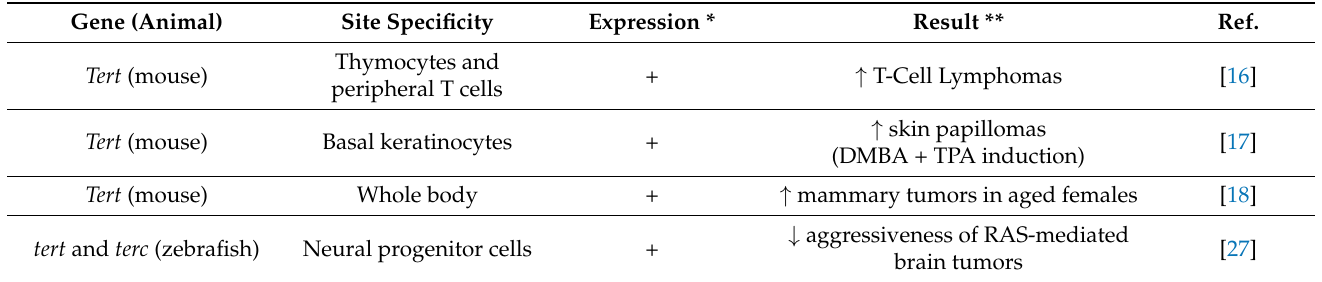
Table 1. TERT cancer models in mice and